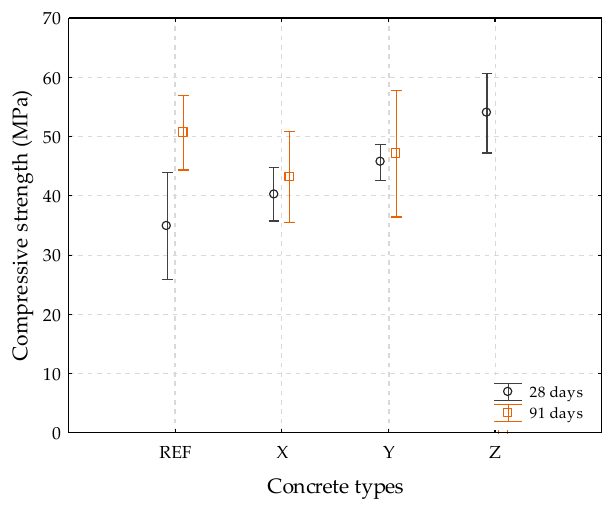
Figure 6. Compressive strength at 28 and 91 days.